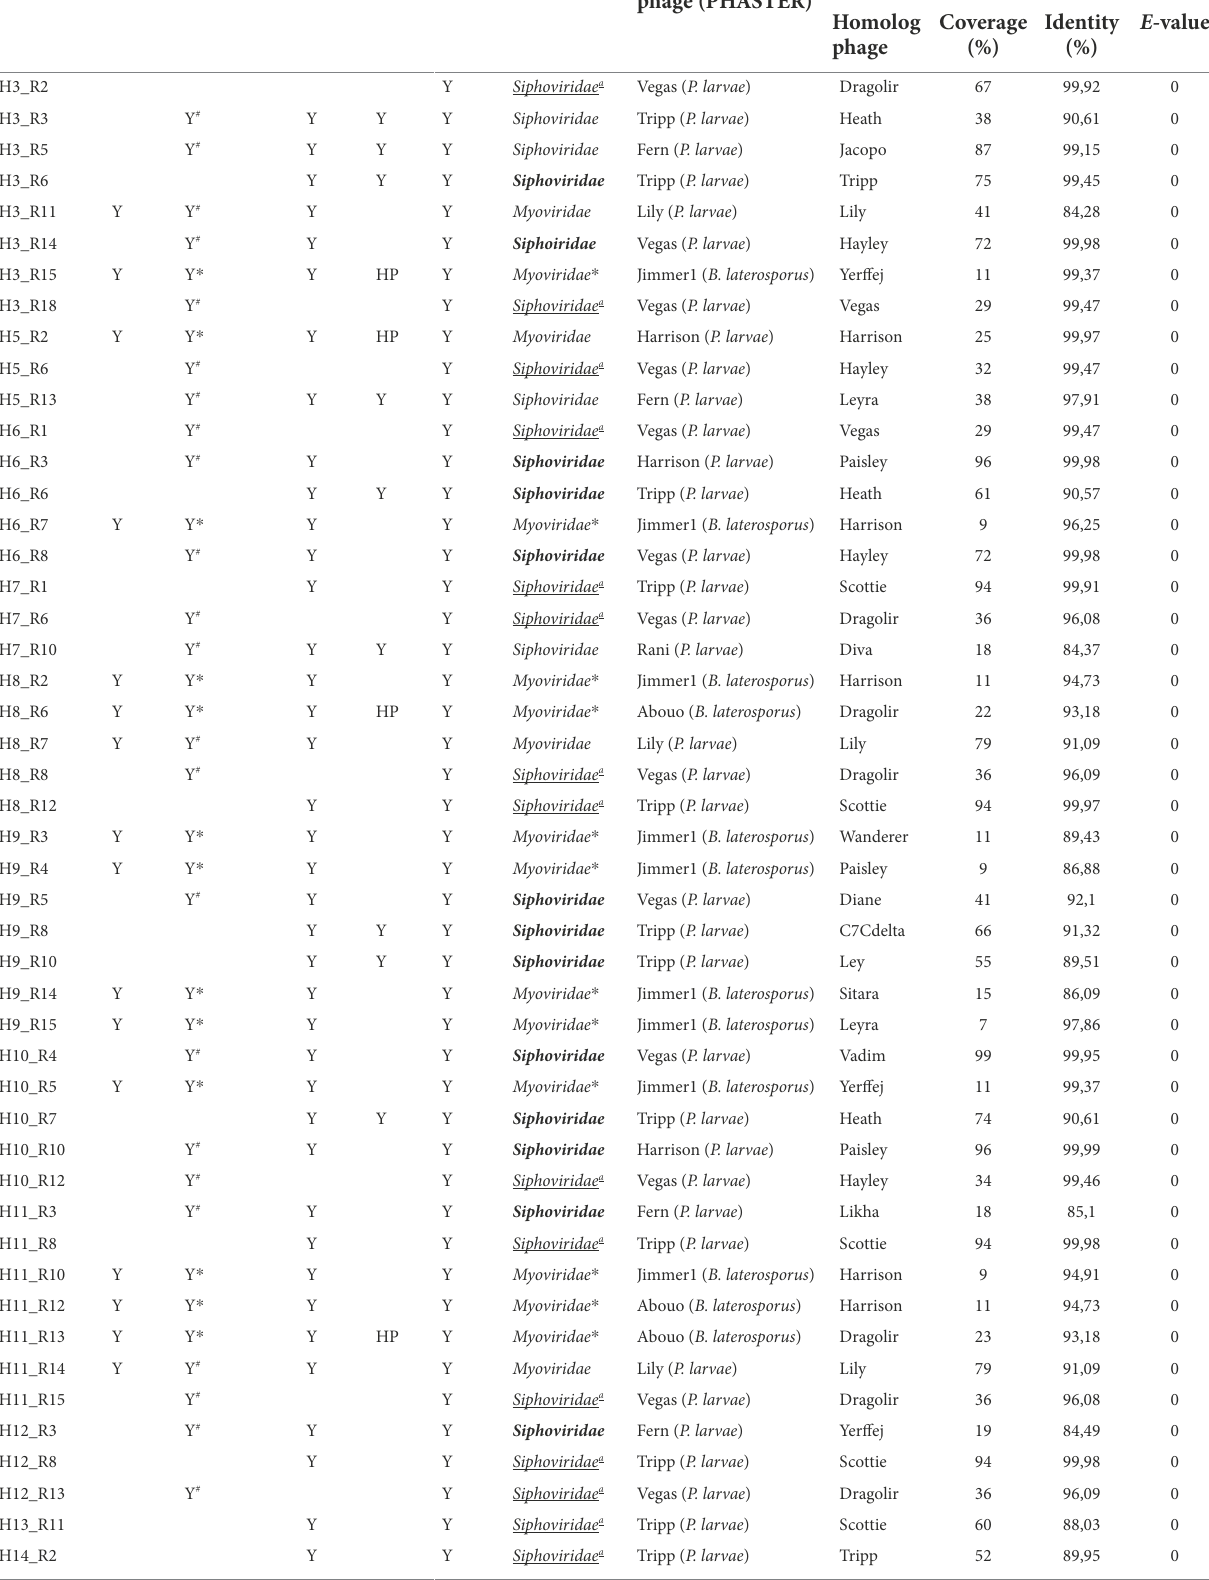
TABLE 3 Taxonomic classification of prophages based on structural proteins present (Y: protein present). Prophage